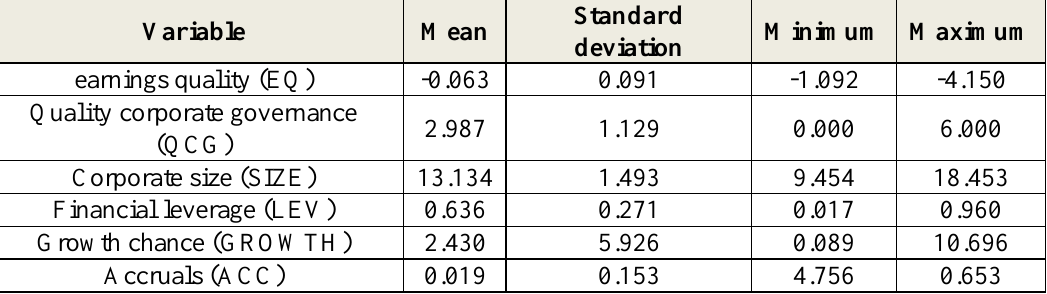
Table 2: Descriptive indices of quantitative research variables